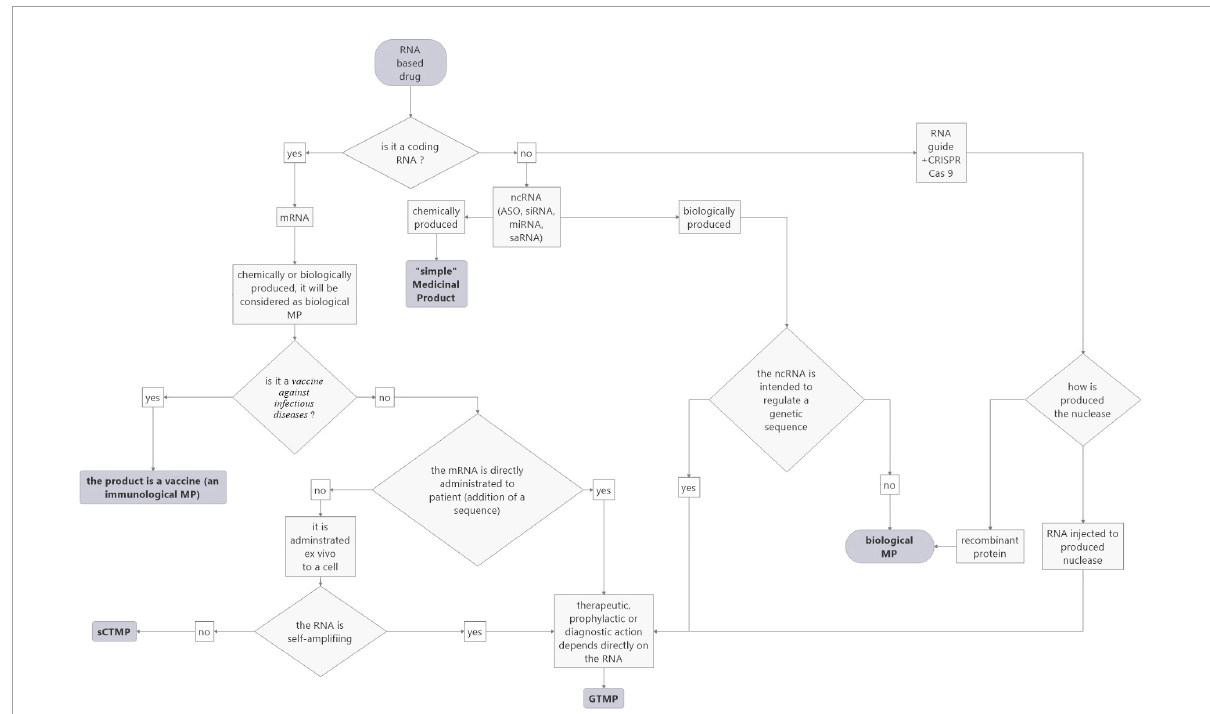
FIGURE3 Proposed flowchart to facilitate the categorization of RNA-based medicinal products according to the current EU